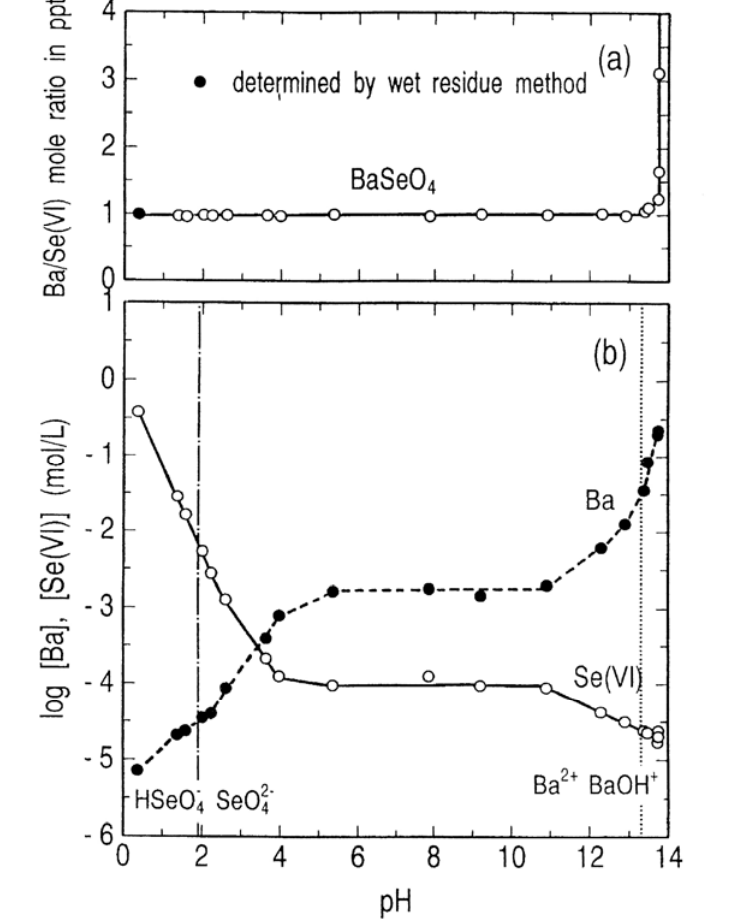
Figure 10. Stability and solubility regions for barium selenates as a function of pH at 25